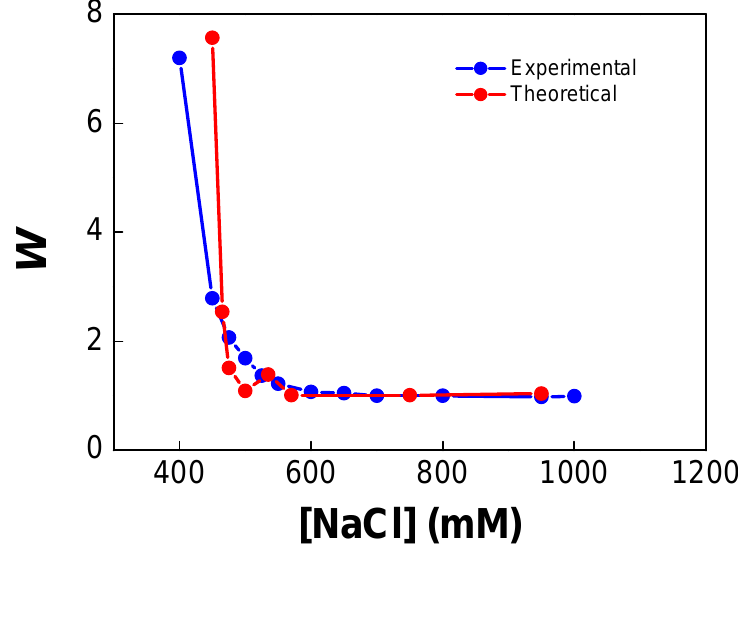
Figure 9. W values of 96-nm latex suspensions at several ionic